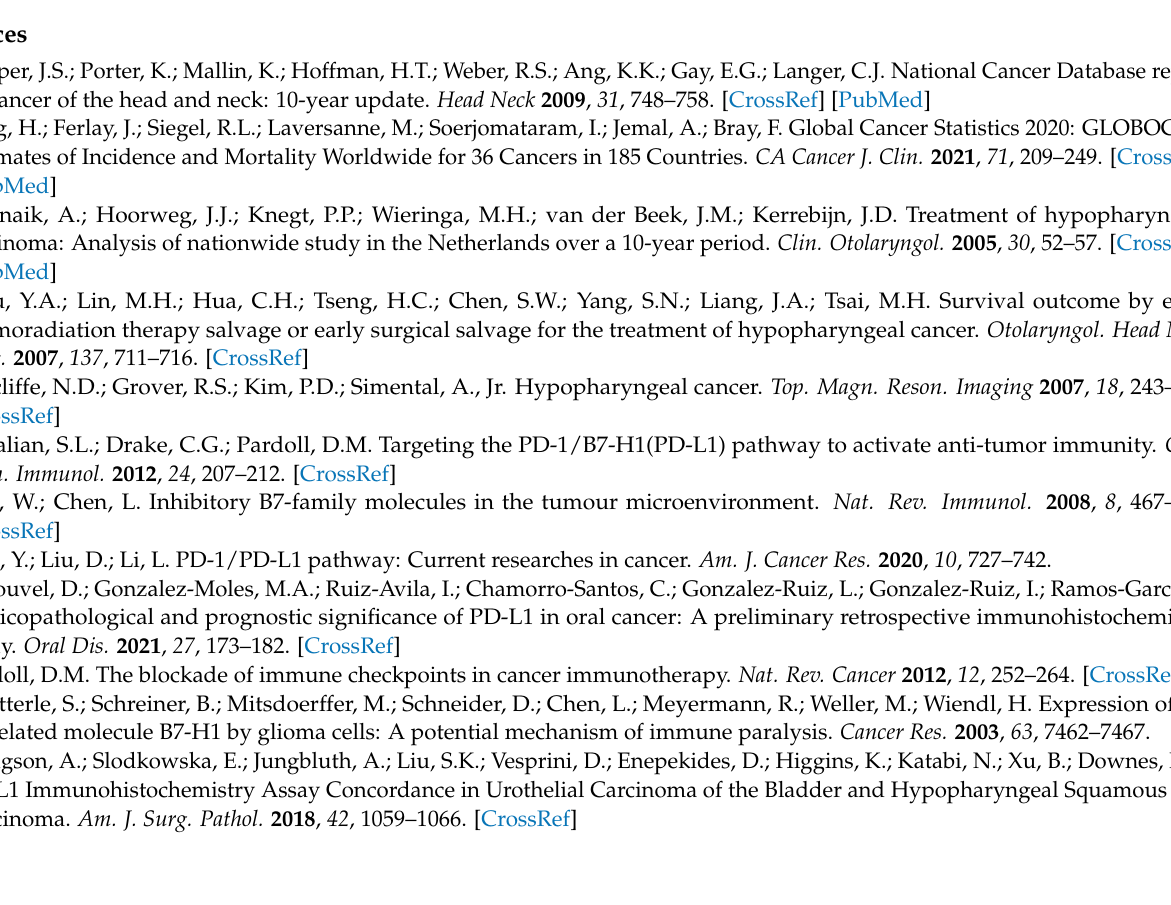
Figure S1: original western blot bands in